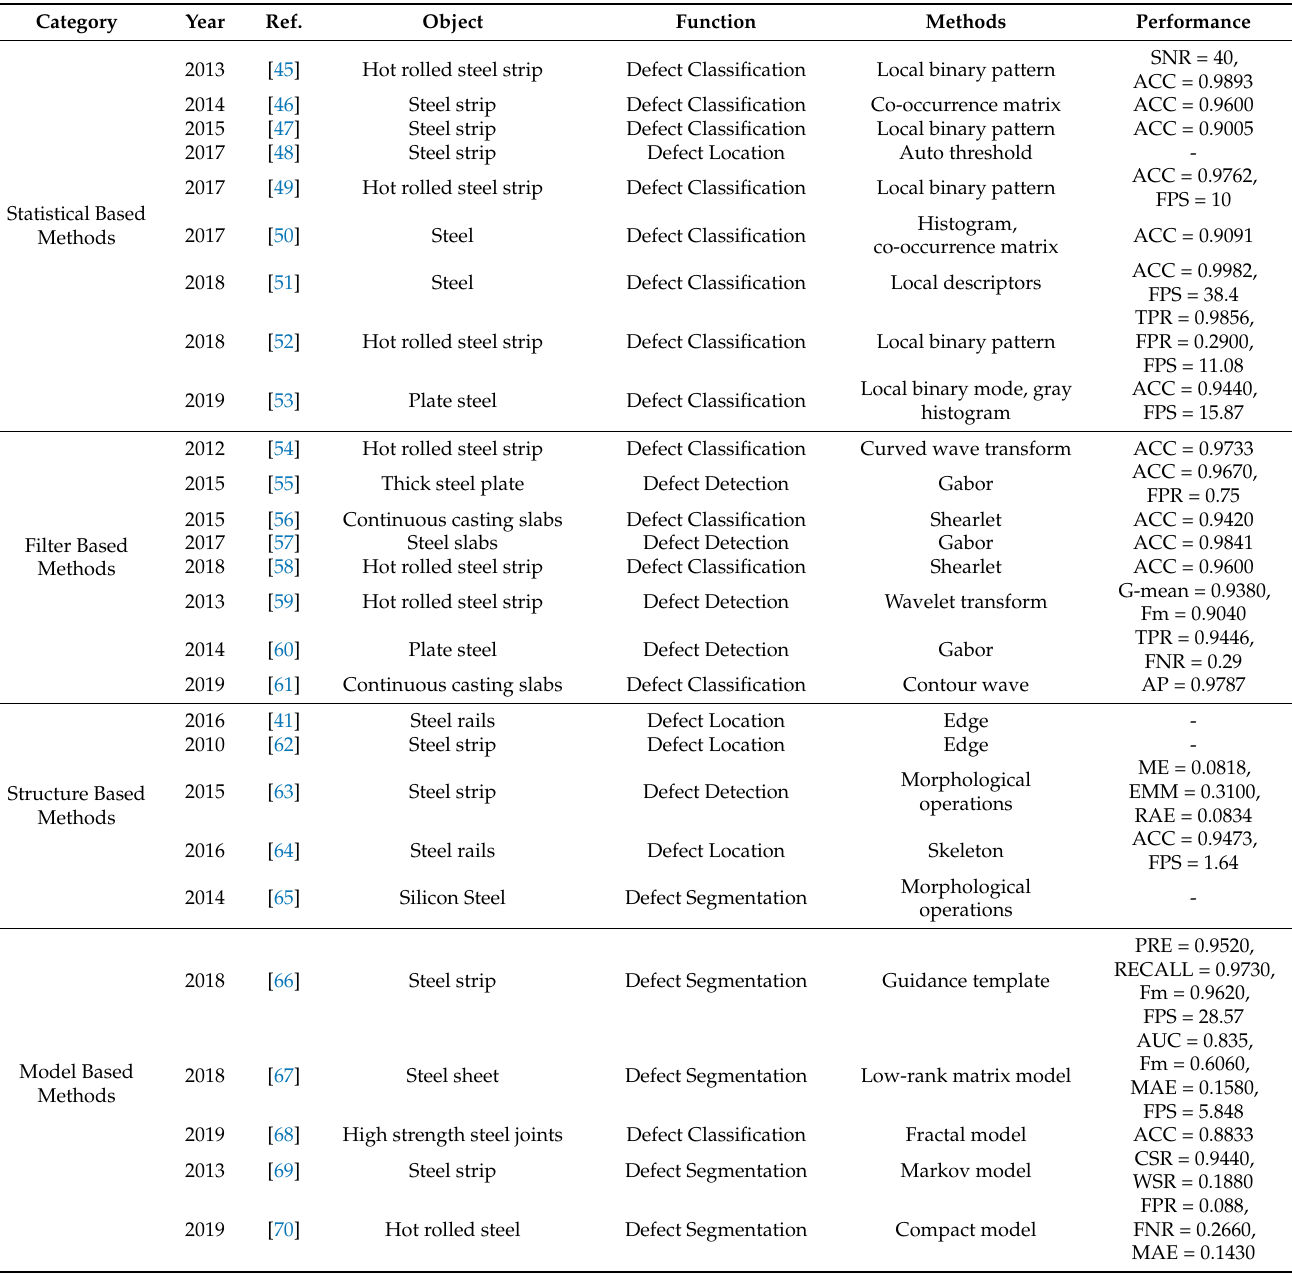
Table 2. Summary of algorithms based on image texture